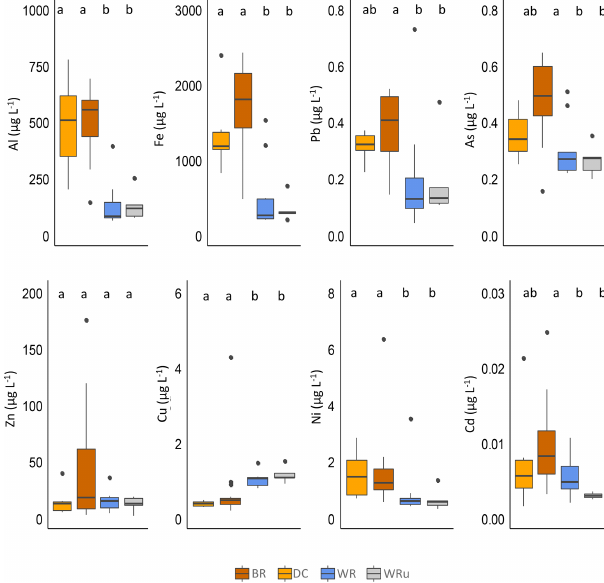
Figure 4. Ranges of selected TM concentrations for different sam- pled water types. Letters represent significantly different groups (Kruskal–Wallis and Dunn’s post hoc multiple test; p < 0 . 05). The black line is the median. The lower and upper levels of the box represent the 25% and 75% quartile, respectively. The lower whisker is smallest observation greater than or equal to lower hinge − 1.5 · IQR (interquartile range). The upper whisker is the largest observation less than or equal to upper hinge + 1.5 ·